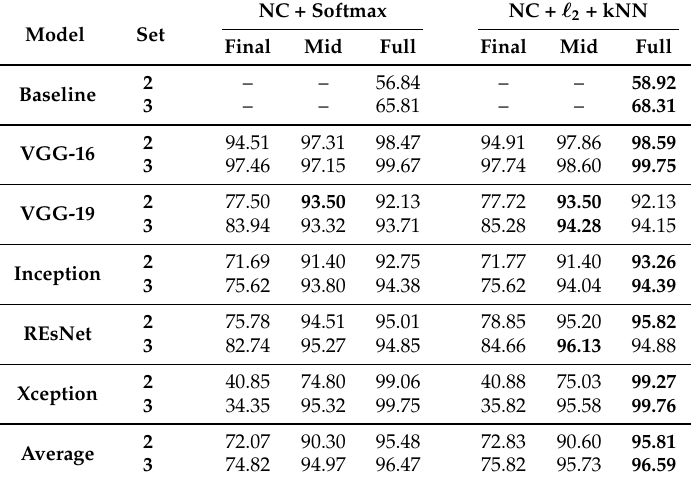
Table 5. F 1 (%) measure obtained for the proposed CNN approaches using two sets from the MASATI dataset considering the sub-class classification. Results for Set 1 are not included because they are the same that can be seen in Table 4 (this set only includes Ship and Non-ship labels). The last rows show the average values excluding the baseline network. The best result for each model and set is shown in bold